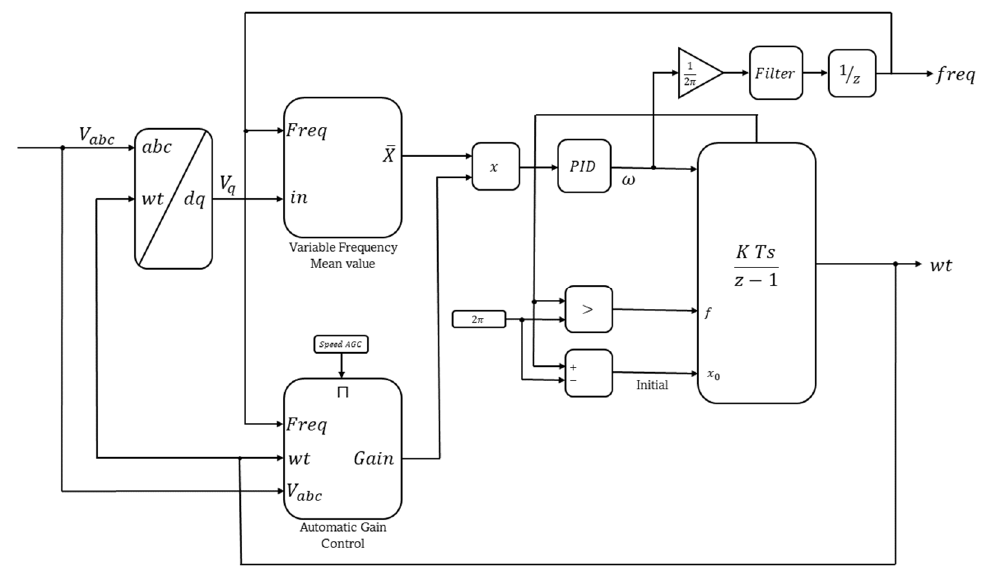
Figure 10. Diagram of the MAF-PLL VCO (voltage-controlled oscillator).